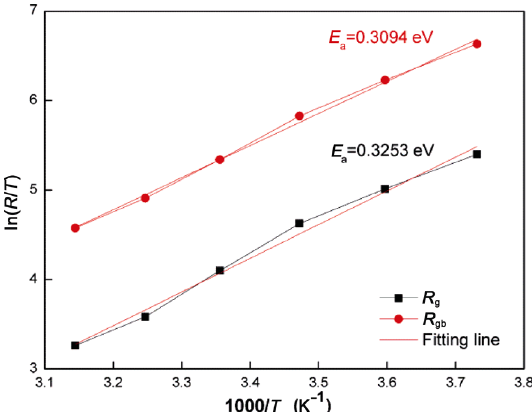
Fig. 12 Curves of ln( R g / T ) and ln( R gb / T )–1000/ T of MCNO thin film with annealing at 750 ℃